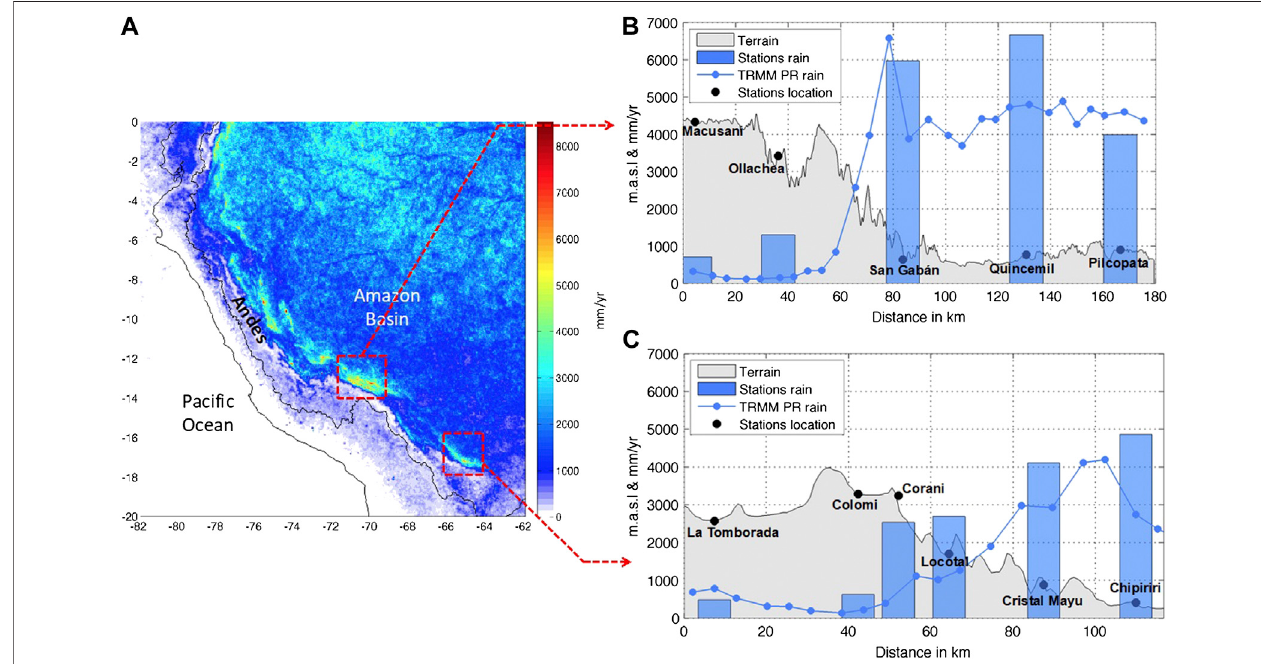
FIGURE5|(A) Meanannualrainfallinwesterntropical SouthAmerica(mm/yr, 1998 – 2012)estimatedusingTRMM2A25. (B) Topographicalpro fi le(gray)andtotal annual rainfall from Macusani to Pilcopata meteorological stations (Peru). The x-axis represents the horizontal distance and the y-axis the altitude (m.a.s.l) and the mean total rainfall (mm/yr) from observations (blue bars) and TRMM 2A25 (blue line). (C) As in (B) but for the La Tamborada-Chipiriri pro fi le in Bolivia highlands. Adapted from Espinoza et al. (2015) © Water Resources Research. Reprinted by permission from John Wiley and Sons.